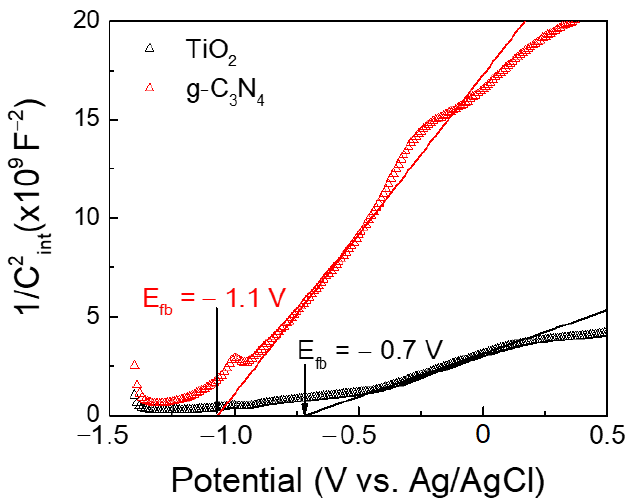
Figure 12. Mott–Schottky analyses performed at 1 kHz in 0.5 M Na 2 SO 4 electrolyte for TiO 2 and g-C 3 N 4 . The potentials were measured against the Ag/AgCl reference. The flat band potentials (E fb ) can be estimated from the linear portion of the graphs, represented in black and red lines, respectively, for TiO 2 and g-C 3 N 4 .